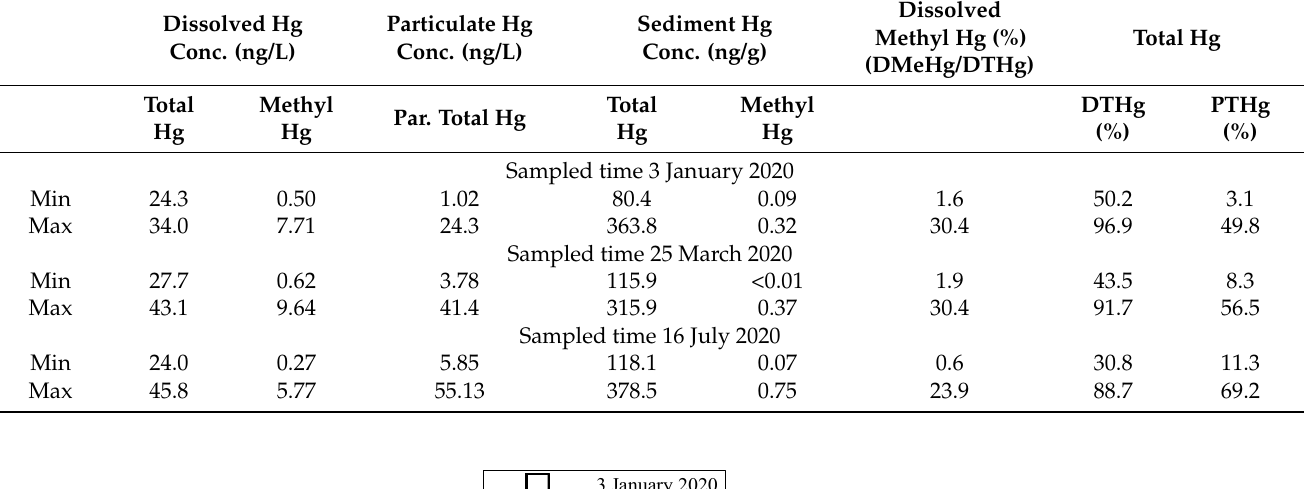
Table 1. Concentration ranges for different species of the analyzed Hg, the percentage of methyl Hg to total Hg in water and sediment samples, and the percentages of dissolved total Hg and particulate total Hg to total Hg in waters in the Danshuei River Estuary, northern Taiwan.